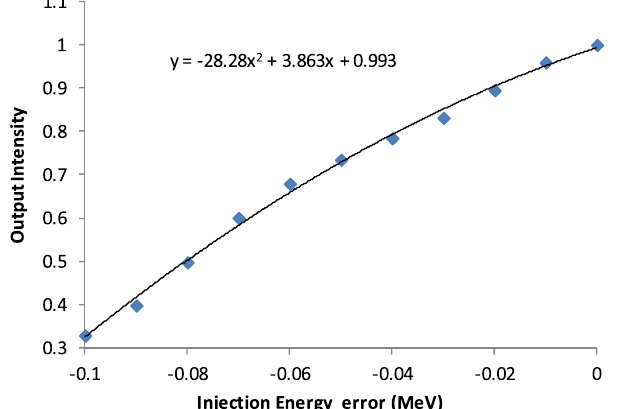
FIG. 8. Computed output intensity normalized to the maximum value versus the injection energy error (the black line is a second- order polynomial fit to the computed data).